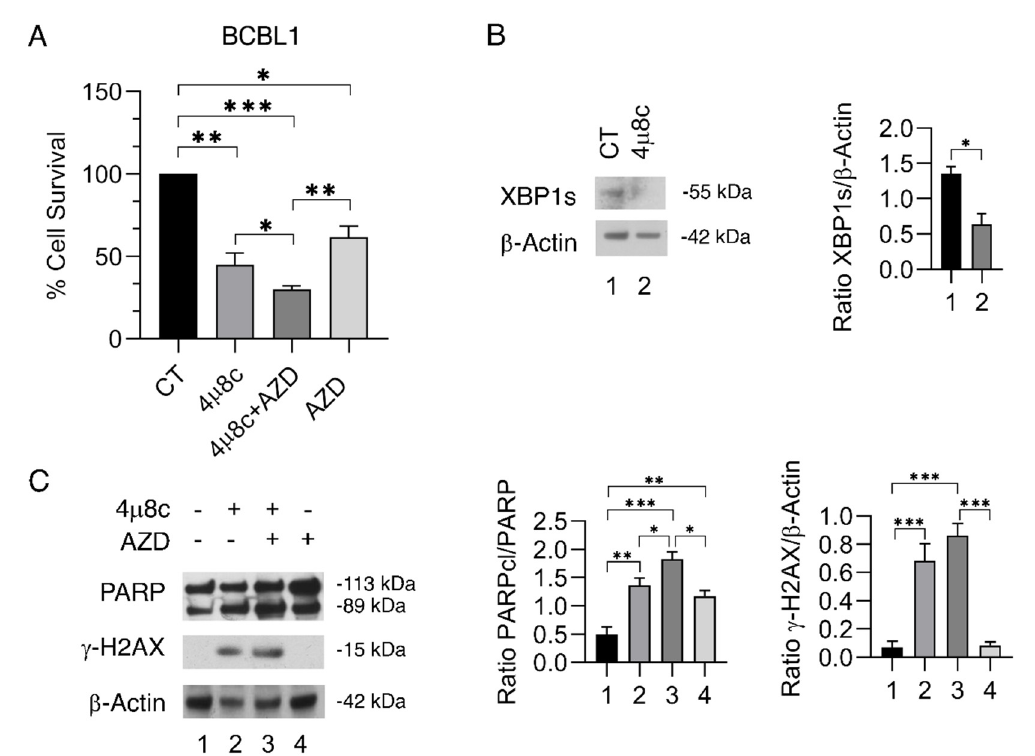
Figure 5. The inhibition of IRE1-alpha/XBP1 axis increases the cytotoxic effect of PARP inhibition also in PEL cells. BCBL1 cells were pre-treated with 4 μ 8C (40 μ M) for 1 h and subsequently treated with AZD2461 (AZD) (40 μ M). ( A ) After 24 h, the cell viability was measured by a Trypan Blue exclusion assay. The histograms represent the mean plus S.D. of live cells as percent of untreated control cells. ( B , C ) Protein expression level of XBP1s, PARP and γ -H2AX was evaluated by Western blot analysis. β -Actin was used as loading control and one representative experiment is shown. The histograms represent the densitometric analysis of the ratio of specific protein and β -Actin of three different experiments. Data are represented as the mean plus S.D. p value: * p < 0.05; ** p < 0.001; *** p <